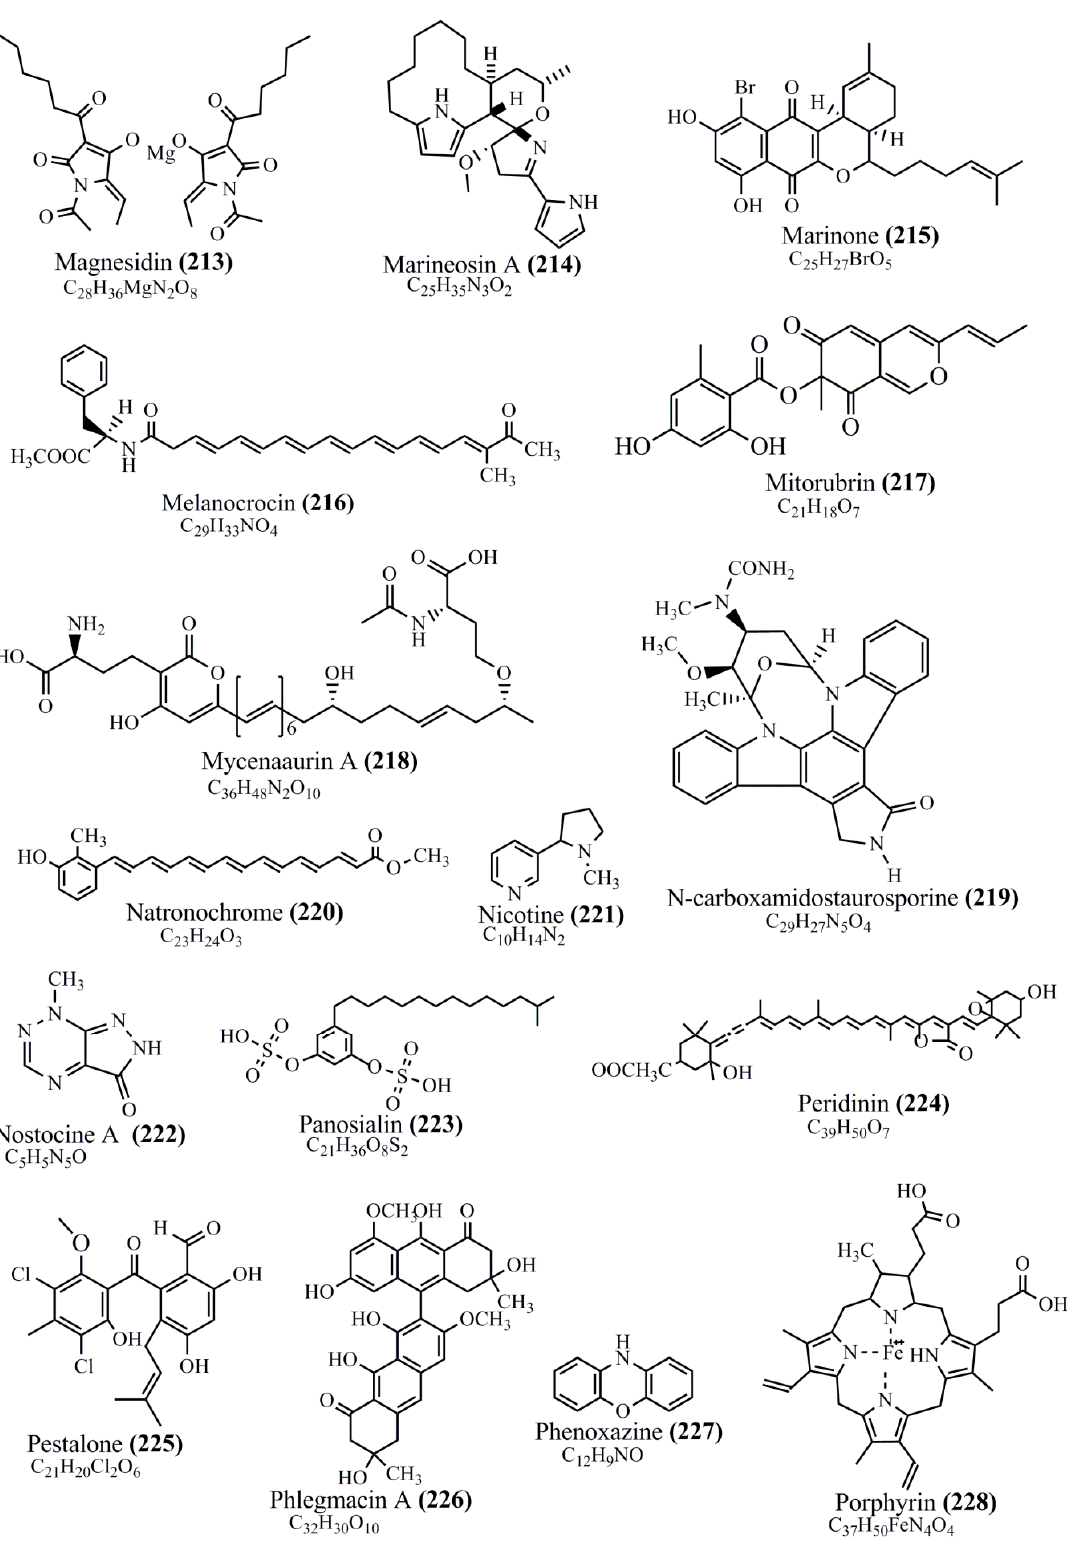
Figure 1. Figure 1. Continued.